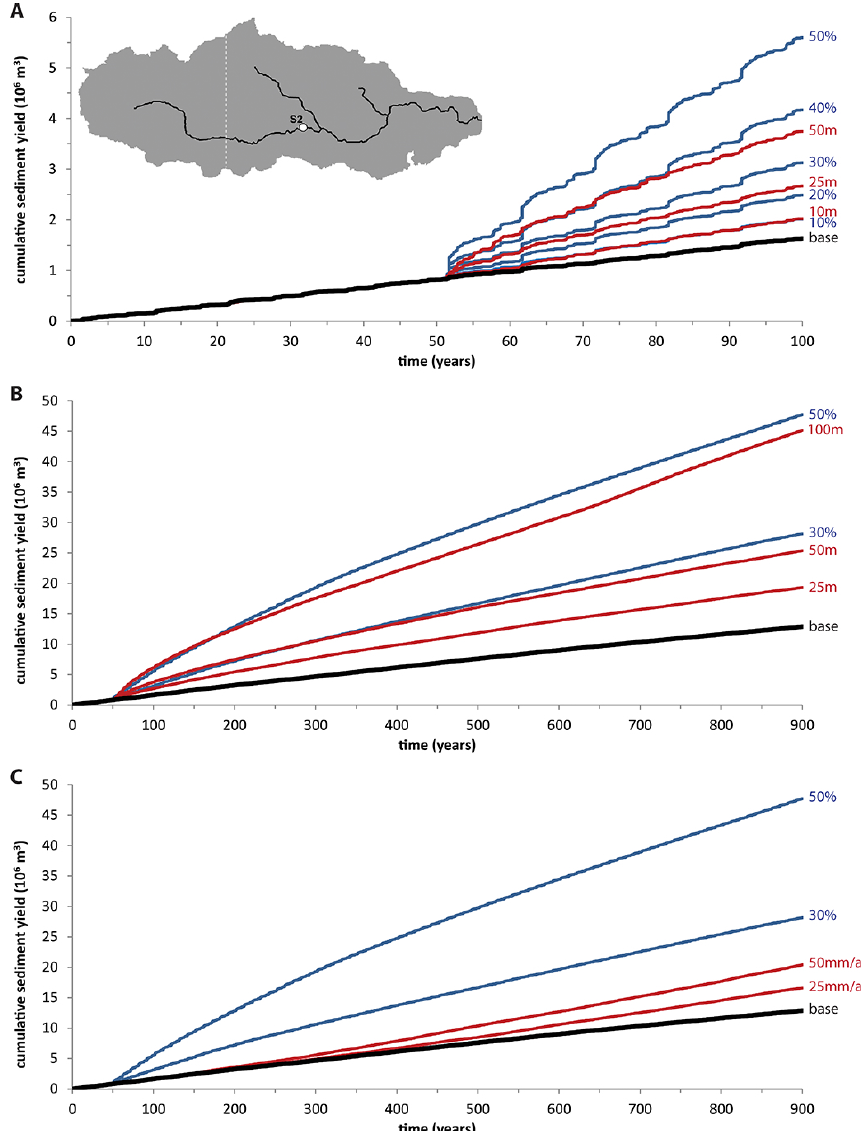
Figure 3. Simulated cumulative sediment yields at point S2 for a range of di ff erent scenarios from E1–E5. (A) 100yr scenarios for rainfall increase and instantaneous uplift (E1, E2). (B) 900yr scenarios for rainfall increase and instantaneous uplift (E3, E4). (C) 900yr scenarios for rainfall increase and gradual uplift (E3, E5). The uplift or increase in rainfall occurred at 50yr. The base scenario (no uplift, no rainfall increase) is shown as a thick black line, rainfall scenarios are shown as blue lines, and tectonic scenarios are shown as red lines. Inset shows location of fault line and measurement point